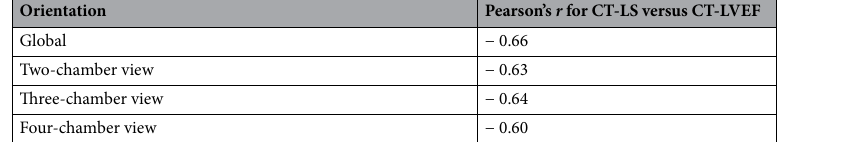
Table 2. Correlation between CT-derived longitudinal strain and CT-derived LVEF in different orientations as well as globally. LS longitudinal Strain, LVEF left ventricular ejection